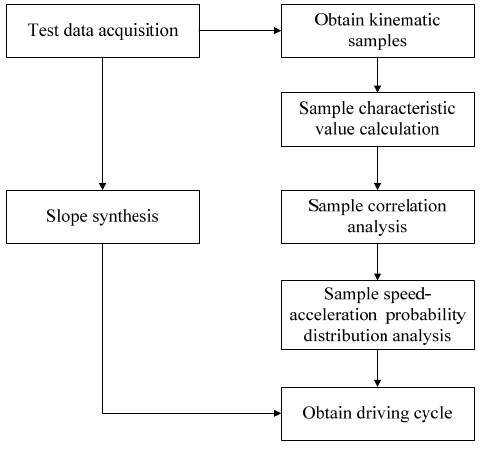
Figure 4. The building process of driving